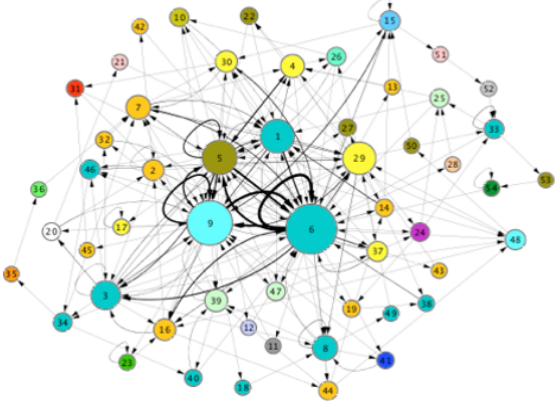
Fig. 2 Foraging behavior is characteristic of human financial patterns around the world. It shows credit card purchase locations of a single person over one month. Circle size is proportional to purchase frequency, and arrows show the likelihood of transition between the purchase locations [20] . Typically people maintain a balance between habits (large circles and arrows) and exploration (small circles and